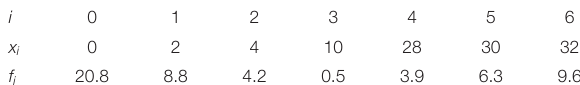
TABLE 1 | Wind data (positive data) [23].